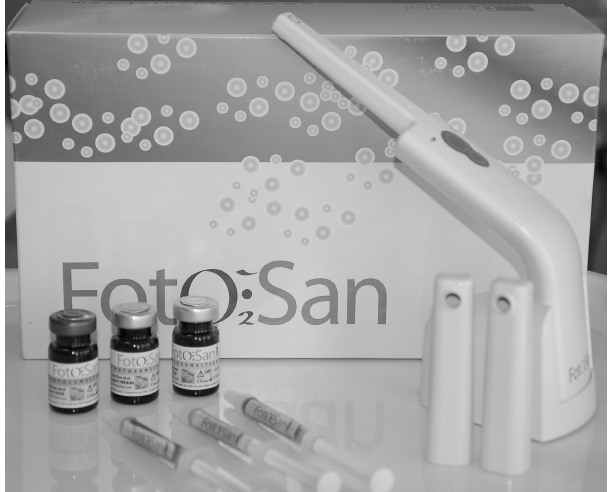
Fig. 1. Complex \FotoSan".